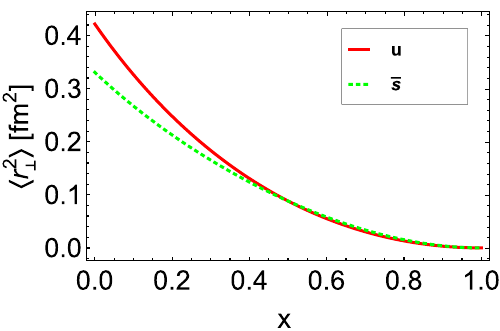
Fig. 8 The width of the distribution of partons in the kaon for a given momentum fraction x defined in Eq. (44)